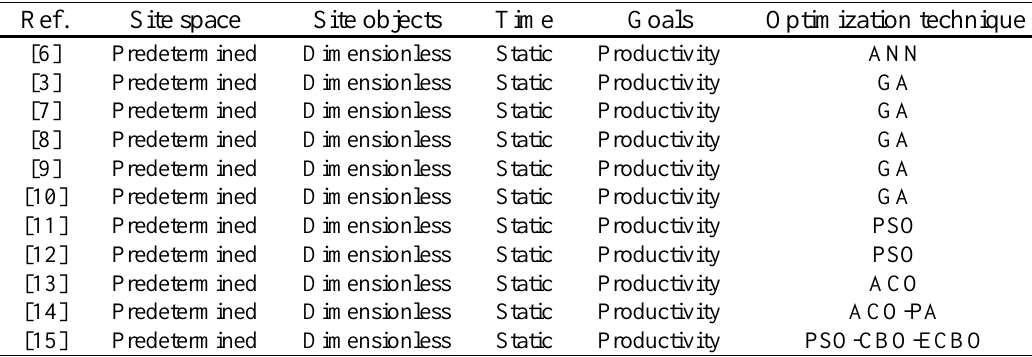
Table 2. References of the various scientific databases related to CSLP.